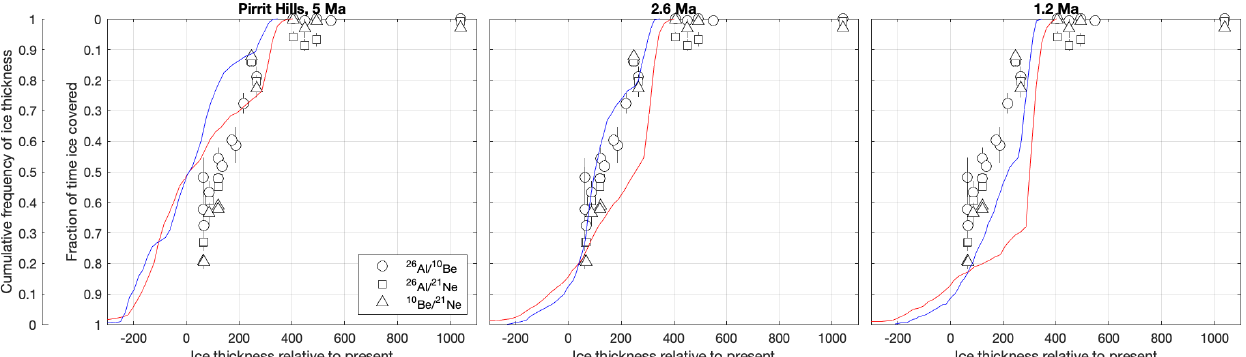
Figure 9. Ice cover frequency estimates derived from cosmogenic-nuclide data at the Pirrit Hills (Spector et al., 2020) compared with ice thickness CDFs for sensitized (red) and desensitized (blue) model simulations over different time periods. In this figure, model CDFs spanning 5Ma, 2.6Ma, or 1.2Ma to present are vertically registered with data such that the “present ice thickness” is the ice thickness in the model grid cell containing the Pirrit Hills in the final time step of the model. The ice cover frequency estimates are computed from data in Spector et al. (2020) and the ICE-D: ANTARCTICA database, using the MATLAB code of Spector et al.